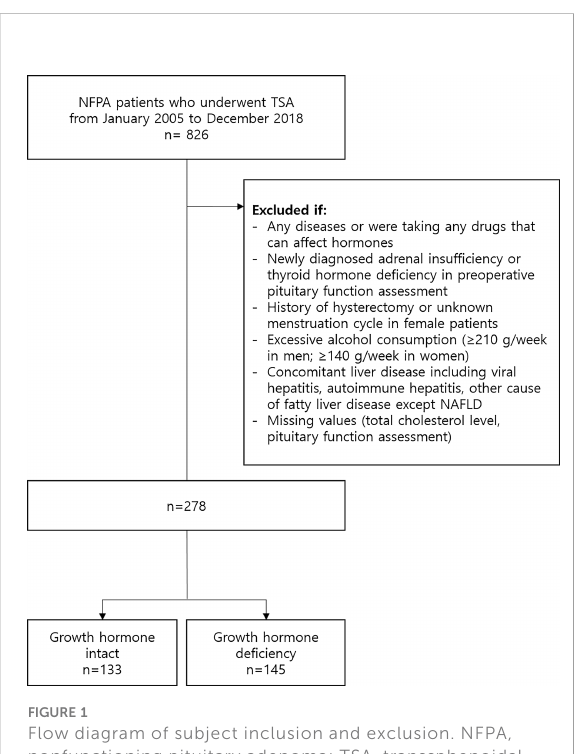
FIGURE 1 Flow diagram of subject inclusion and exclusion. NFPA, nonfunctioning pituitary adenoma; TSA, transsphenoidal adenomectomy; NAFLD, nonalcoholic fatty liver